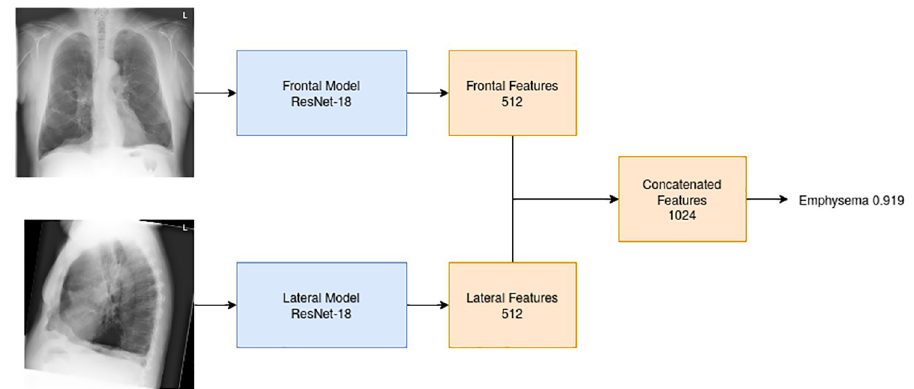
Fig 4. Illustration of the black-box model. For each view, we define a model with 512 outputs. The outputs from the two models are concatenated and the probability of emphysema is predicted from this final layer. The indicated score is calculated using the CXRs shown in the figure for this specific